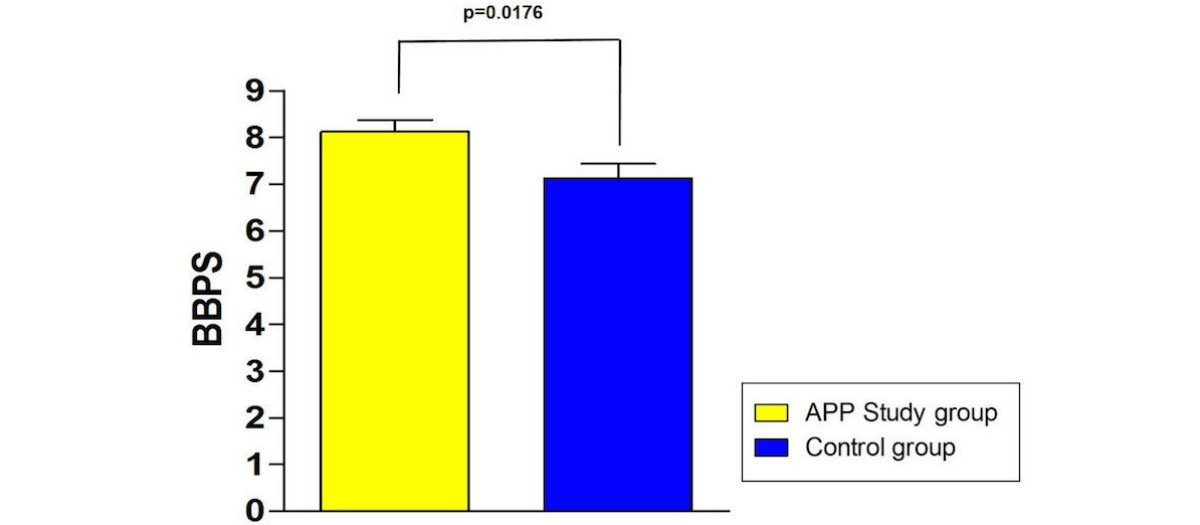
Figure 3. Total Boston bowel preparation scale score with significantly higher grade for smartphone app–supported